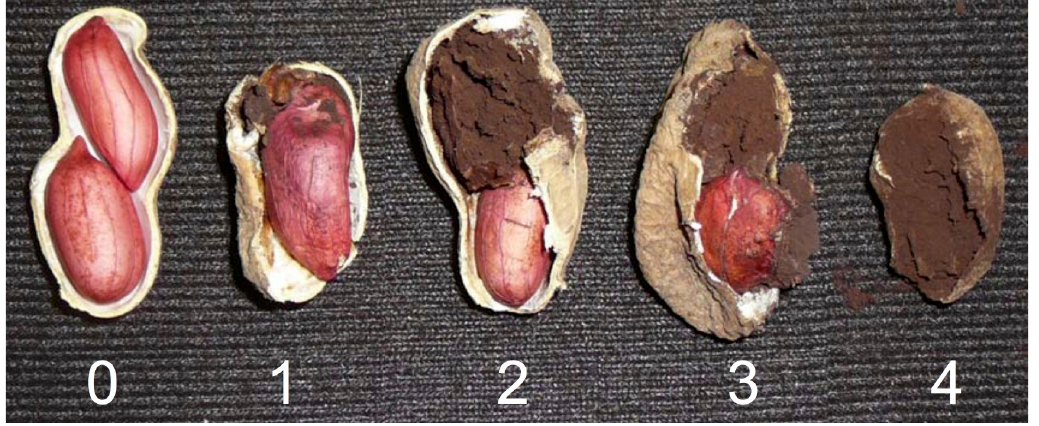
Fig 1. Peanut smut severity scale. Classes on a 0 to 4 scale, where 0 = healthy pods, 1 = normal pod with a small sorus in single kernel, 2 = deformed or normal pod with half of the kernels affected, 3 = deformed pod and one completely smutted kernel, and 4 = deformed pod with all kernels completely smutted